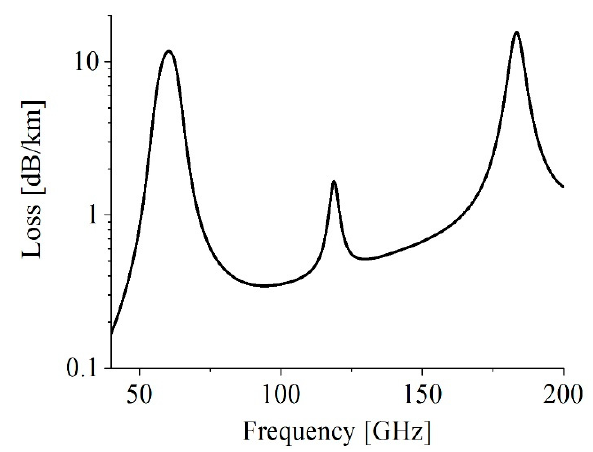
Figure 9. Atmospheric attenuation of the millimeter-wave range [31].